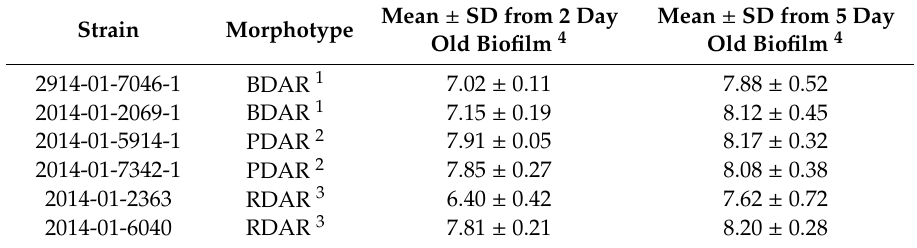
Table 1. Strains, morphotype, and the mean log 10 colony forming units (CFU) from biofilm after two and five